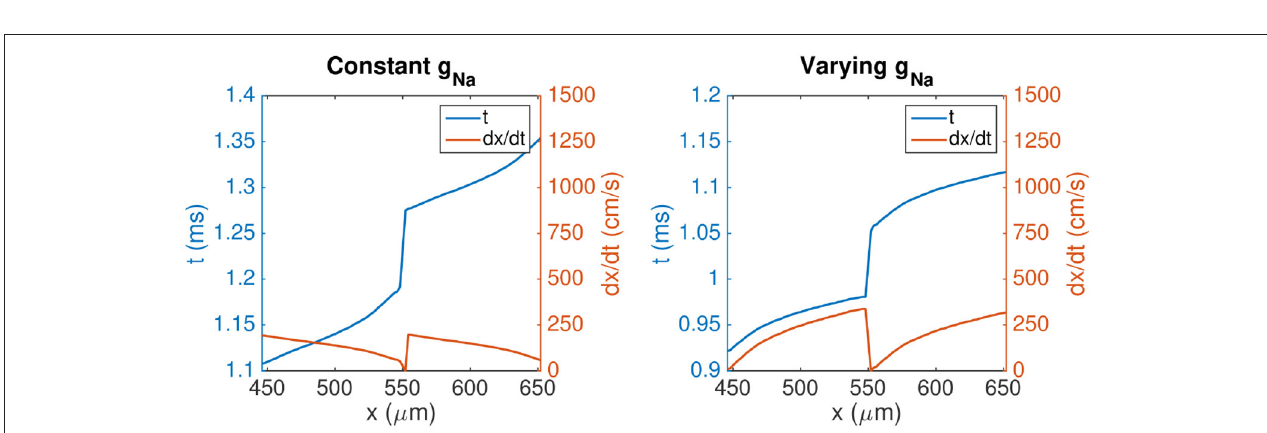
FIGURE 9 | Activation times and conduction velocities along the length of two cells in a simulation of 10 × 1 cells with different distributions of g Na , similar to the simulations shown in Figure 7 . The blue line shows the points in time when the membrane nodes corresponding to each x -value along cells number five and six first reach a membrane potential of 0 mV. The orange line shows the corresponding conduction velocity along the two cells, computed from a piecewise second order polynomial approximation of the activation curves. The parameters used in the simulations are given in Tables 1 , 6 , except that we use 1 t = 0.0005 ms. Note that the values of the left y -axis (representing activation time) is different in the two plots, but that the scaling of the axis is the same in both plots.